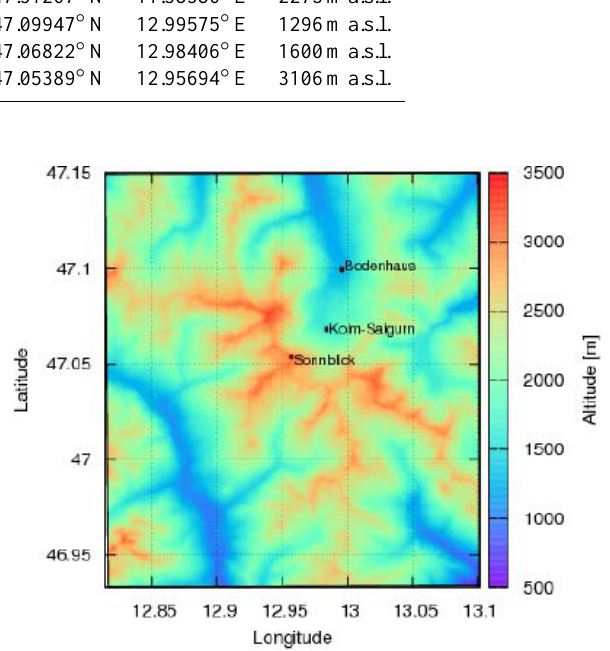
Fig. 1. The digital elevation map used within the 3-D-radiative transfer model for the Innsbruck section. The three measurement sites within this study region are also shown. Figure 2: The digital elevation map used within the 3-D- radiative transfer model for the Sonnblick section. The three measurement sites within this study region are also shown.